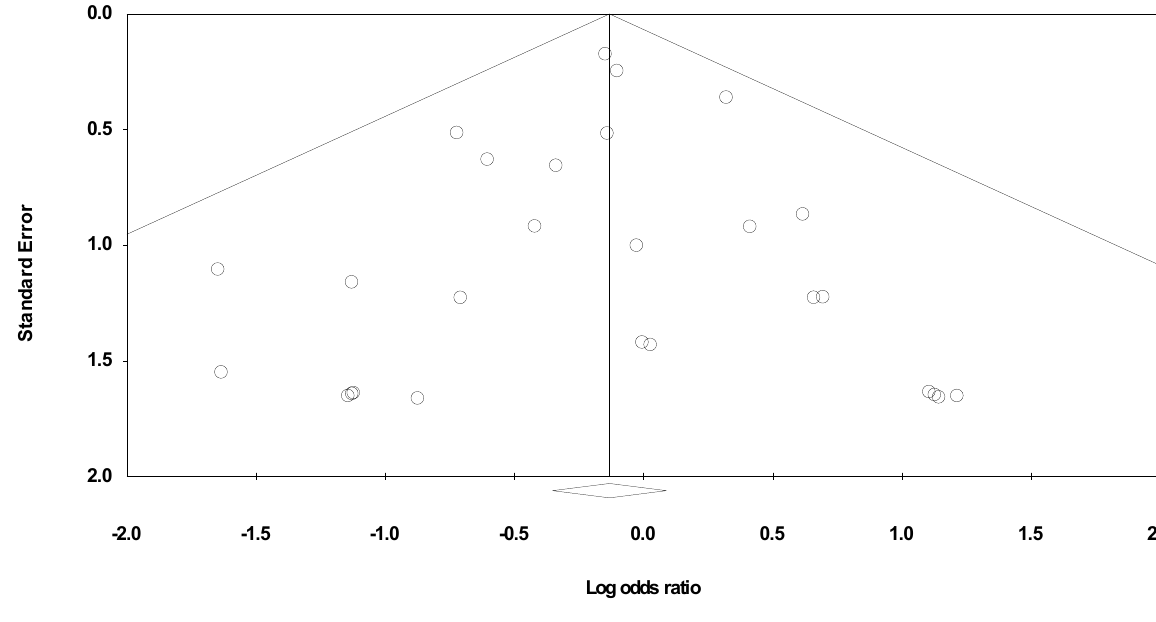
Supplementary Fig. 3 – Funnel plot for the incidence of mortality. Begg and Mazumdar’s test (P value): 0.692 and Egger’s test (P value):